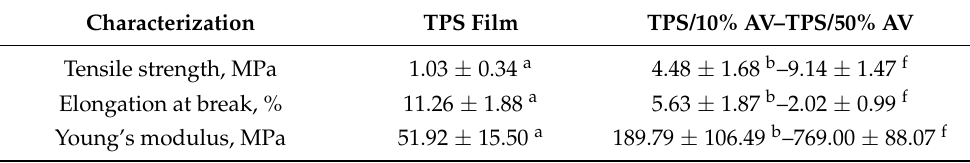
Figure 8. ( a ) The FTIR spectra for TPS, AV gel, and TPS + 30% AV and ( b ) the FTIR spectra of TPS film with different AV gel concentrations. Table 2. Summary of